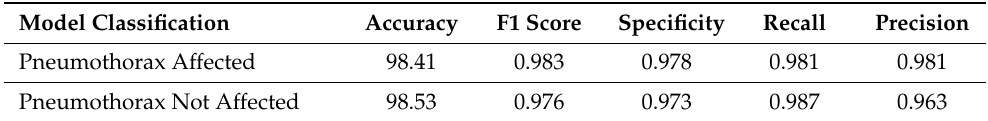
Table 6. Overall results obtained from the proposed model.